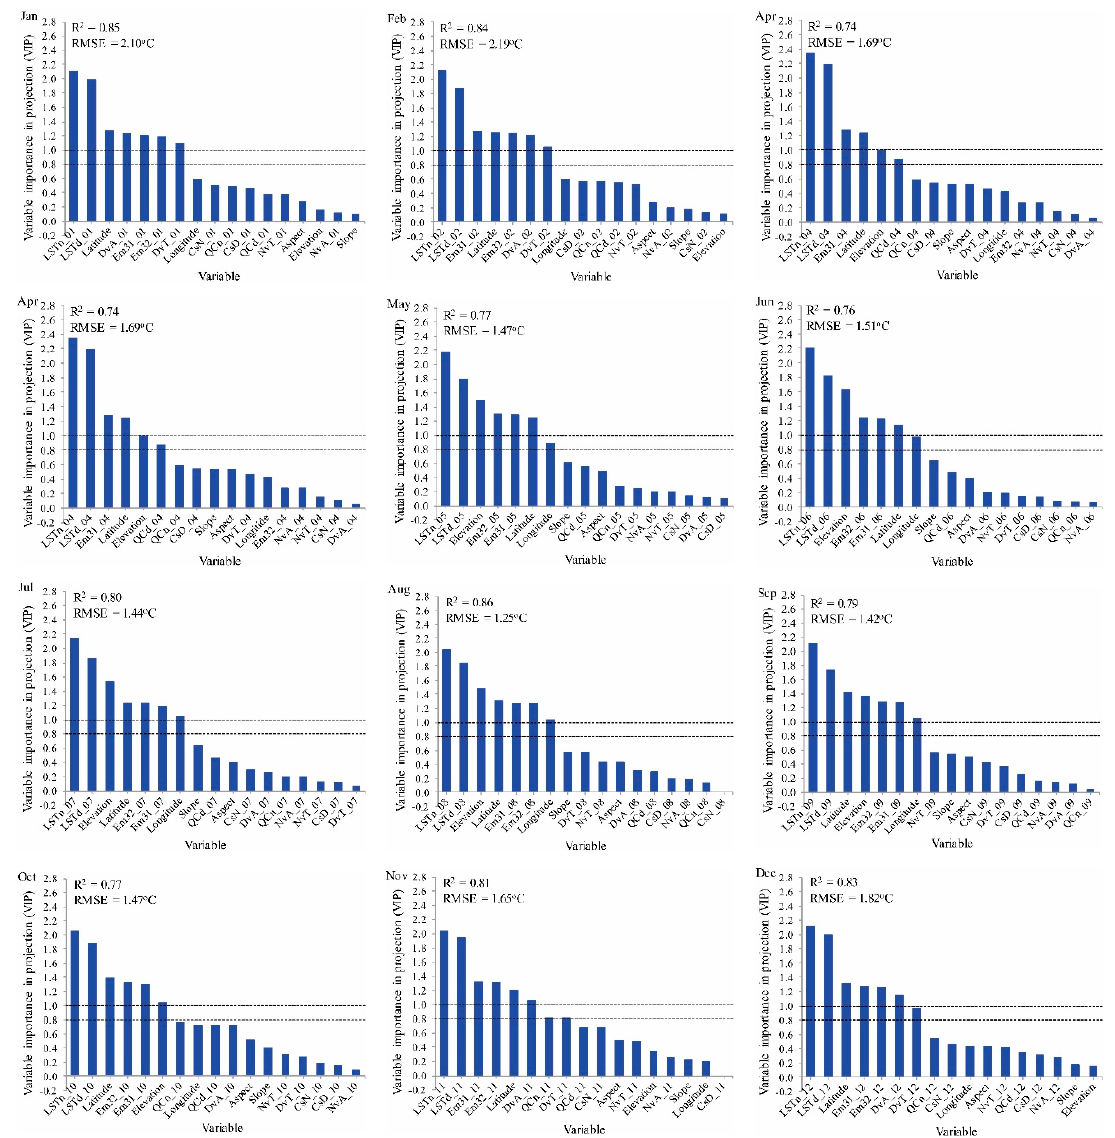
Figure A1. Variable importance in projections (VIPs), R 2 , and RMSE for the 17 predictor variables in the twelve-monthly PLSR models.